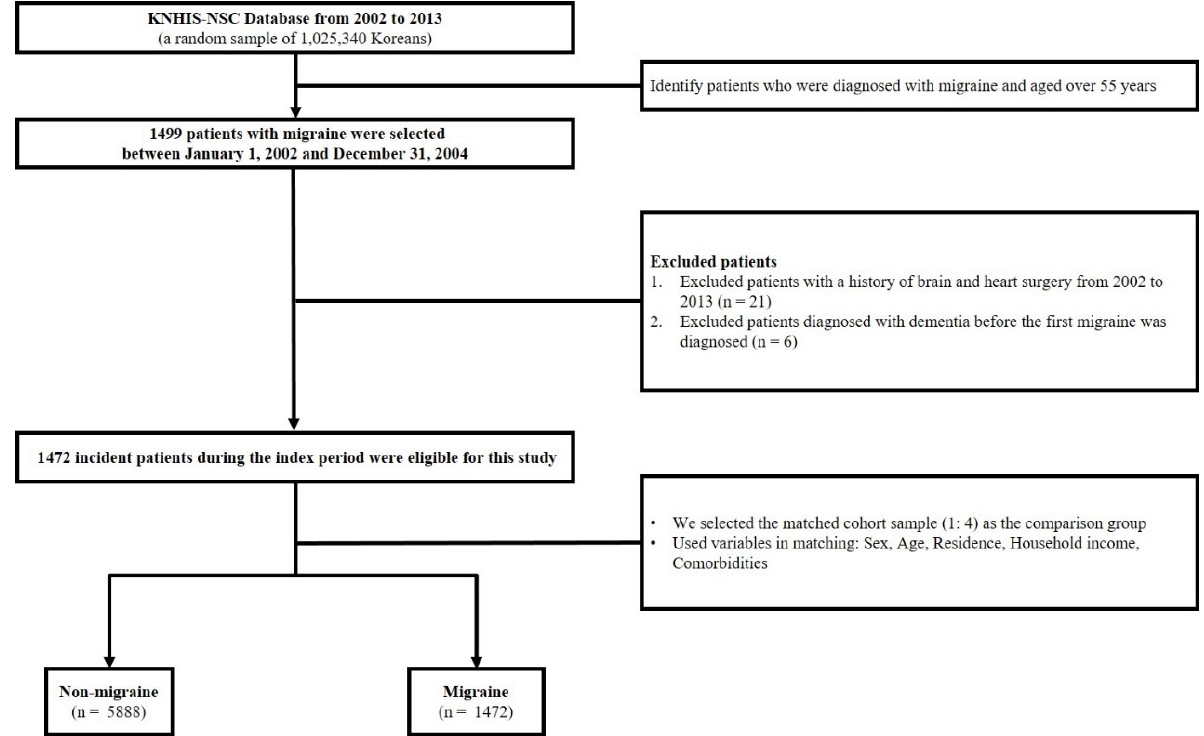
Figure 1. Schematic description of study design.